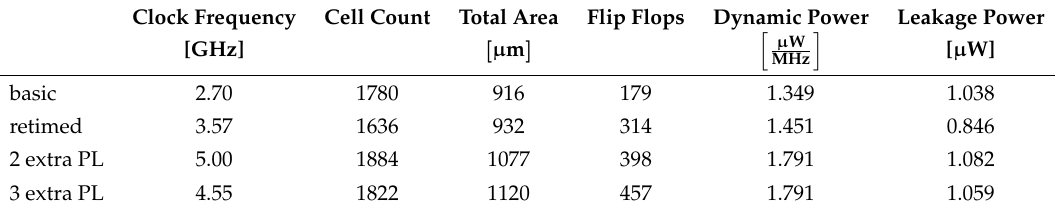
Table 5. ASIC implementation results for the resampler in 14 nm FinFET GF technology using 16 bits for d